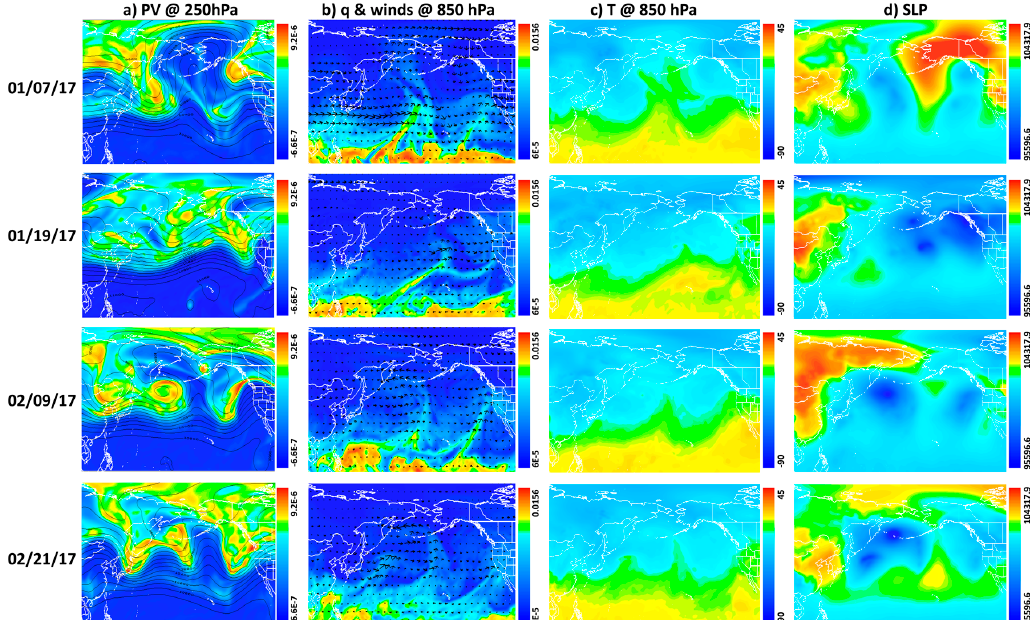
Figure 2. Longitude-latitude cross section of ( a ) potential vorticity (PV) at 250 hPa with PVU = 1.5 (1 PVU = 10 − 6 m − 2 s − 1 K kg − 1 ; ( b ) water vapor mixing ratio (q, g kg − 1 ) overlaid by horizontal wind vector (m s − 1 ) at 850 hPa; ( c ) temperature (in ◦ C) at 850 hPa; ( d ) sea level pressure (Pa) at 00 UTC 01 / 07 / 17 (1st row), 01 / 19 / 17 (2nd row), 02 / 09 / 17 (3rd row), and 02 / 21 / 17 (4th row) obtained from the ERA-Interim reanalysis